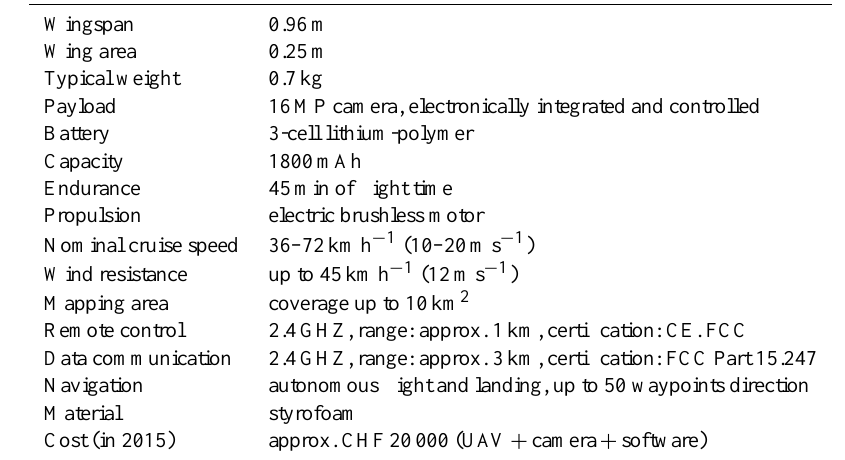
Table A1. Detailed characteristics of the UAV.